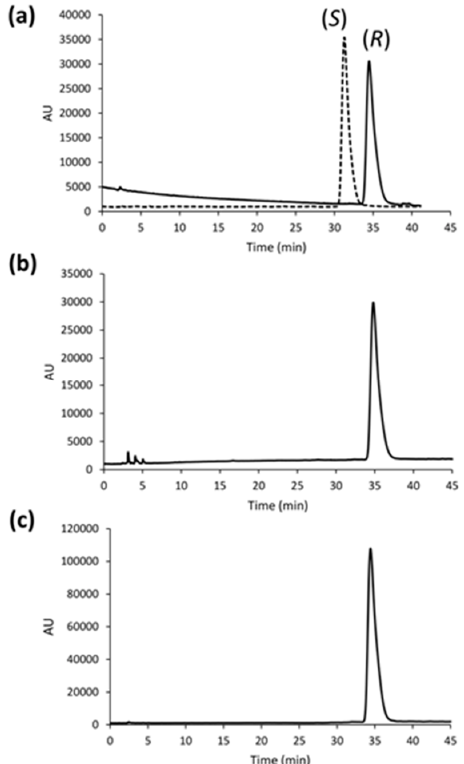
Figure 3. Enantioselective analysis of ( a ) ruxolitinib phosphate standard with chiral stationary phase (CSP) 1 (solid line) and CSP 2 (dotted line), according to the inverted chirality columns approach (ICCA) method; ( b ) ruxolitinib phosphate contained in the commercial tablets; ( c ) ruxolitinib phosphate contained in the galenically prepared capsules. Experimental conditions: columns, (R,R)- Whelk-O1 (CSP 1) and (S,S)-Whelk-O1 (CSP 2) (both 250 × 4.6 mm ID, 5 μ m, 100 Å pore size; containing the 1-(3,5-dinitrobenzamido)-1,2,3,4-tetrahydrophenanthrene chiral selector (SO) motif; eluent, water/ACN (70:30, v / v ); flow rate, 1.0 mL/min; column temperature, 25 °C). Y-axis is in